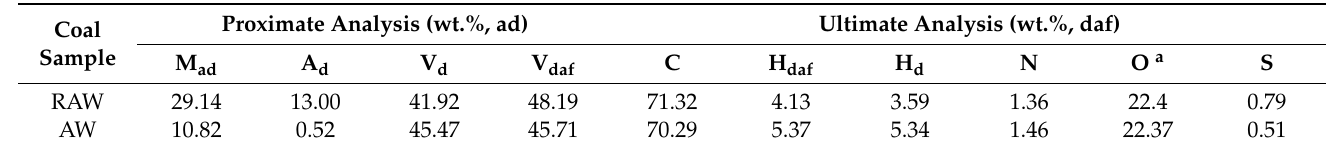
Table 1. Proximate and ultimate analysis of raw and AW